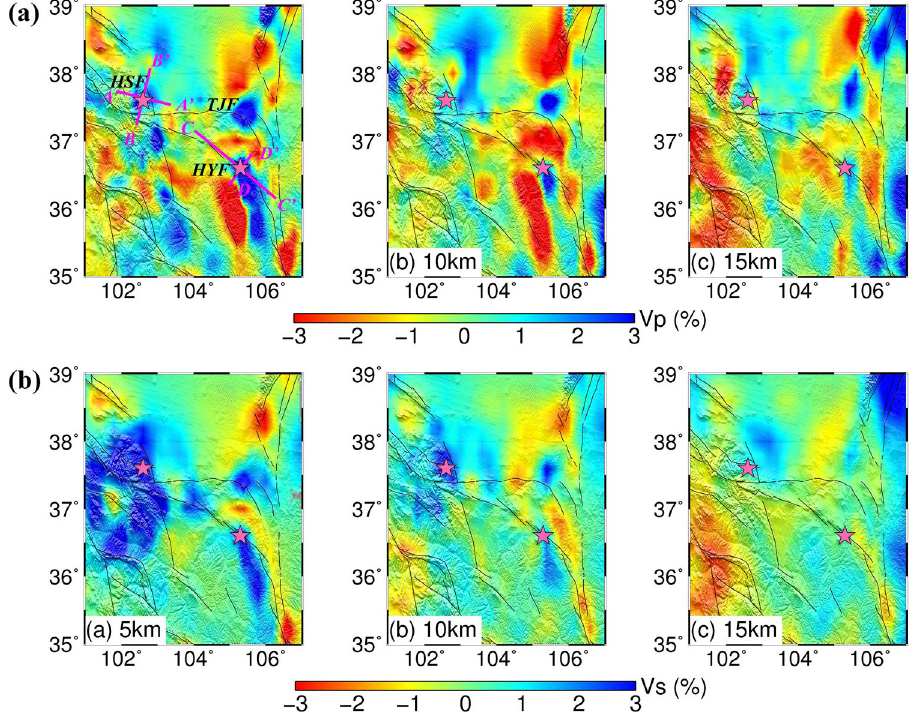
Figure 3. Tomographic Vp image ( a ) and Vs image ( b ) around the source regions of the 1920 Haiyuan and 1927 Gulang earthquakes, respectively. The magenta lines in Figure ( a ) represent the location of the four vertical tomographic profiles named AA ′ , BB ′ , CC ′ and DD ′ in Fig.